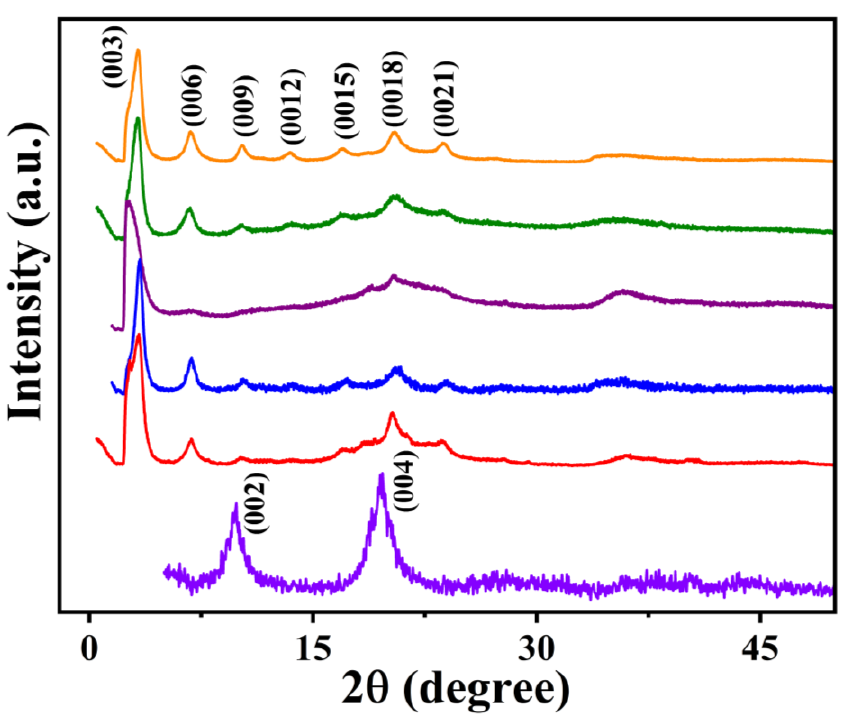
Figure 4. PXRD patterns of Li-Mg-Al-NO 3 LDH (data in violet) and Li-M-Al-DS LDHs (M = Mg (data in red), Co (data in blue), Ni (data in purple), Cu (data in olive green), and Zn (data in orange)).